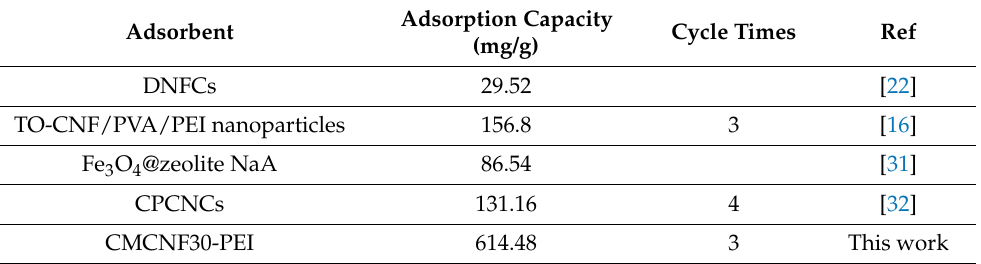
Table 5. Comparison of Cu 2+ adsorption capacity of different